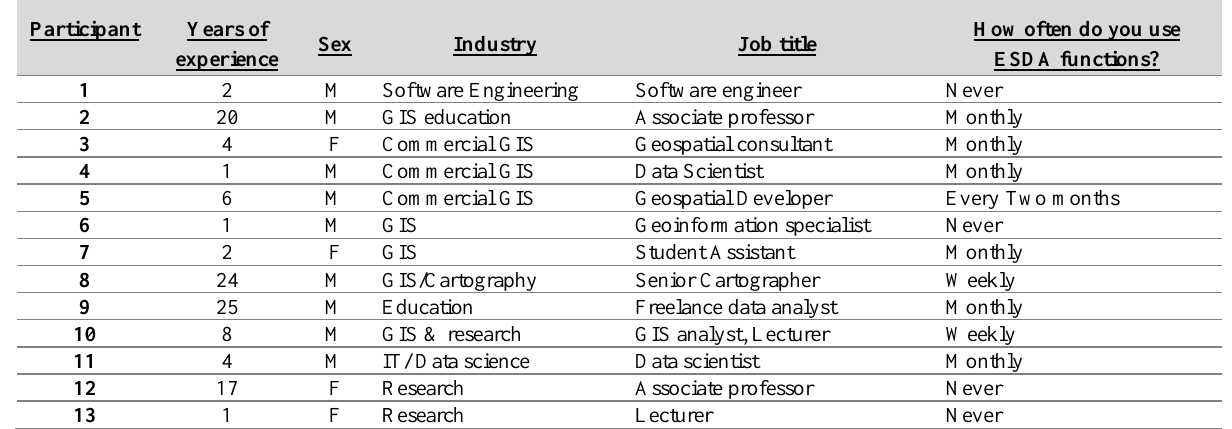
Table 3. Demographics of the interview